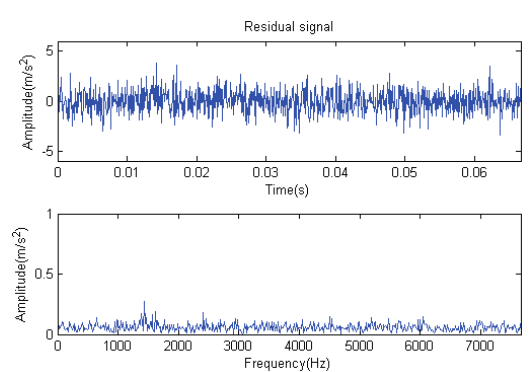
Figure 21. Residual signal.